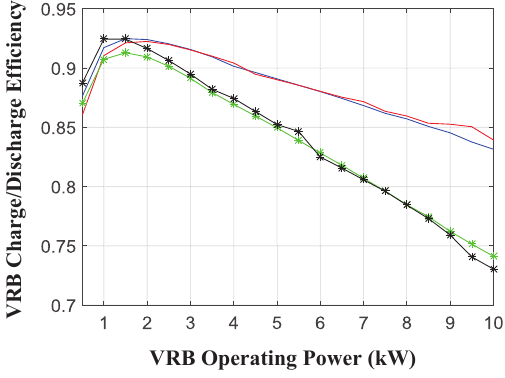
Figure 4. VRB charge and discharge efficiencies with respect to varying battery power: ‘ − ’ VRB charge efficiency with SOC starting at 10% (blue) and 40% (red); ‘ ∗− ’ VRB discharge efficiency with SOC starting at 80% (green) and 50% (black).